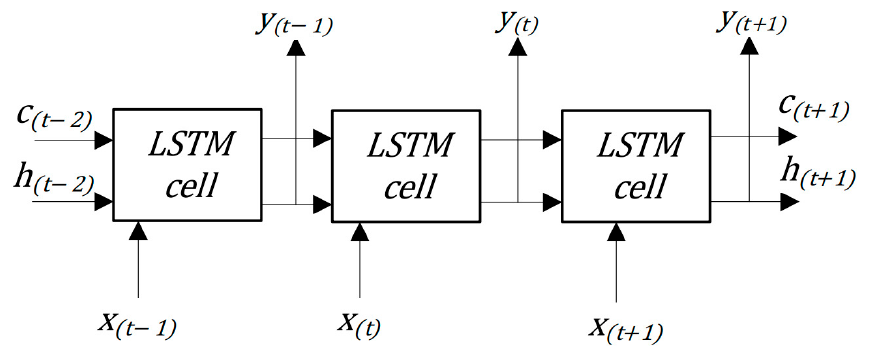
World Electr. Veh. J. 2022 , 12 , x FOR PEER REVIEW Figure 2. Sequential Structure of LSTM Repeat Unit. Figure 2. Sequential Structure of LSTM Repeat Unit.